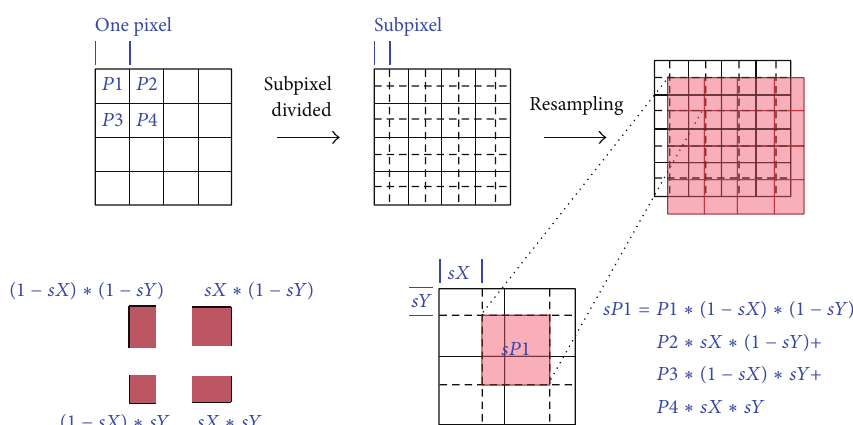
Figure 6: Subpixel and formula (sP1) for estimating its gray level. For block that must be resample owing to subpixel displacement, gray level of every pixel must be recalculated using estimation formula.